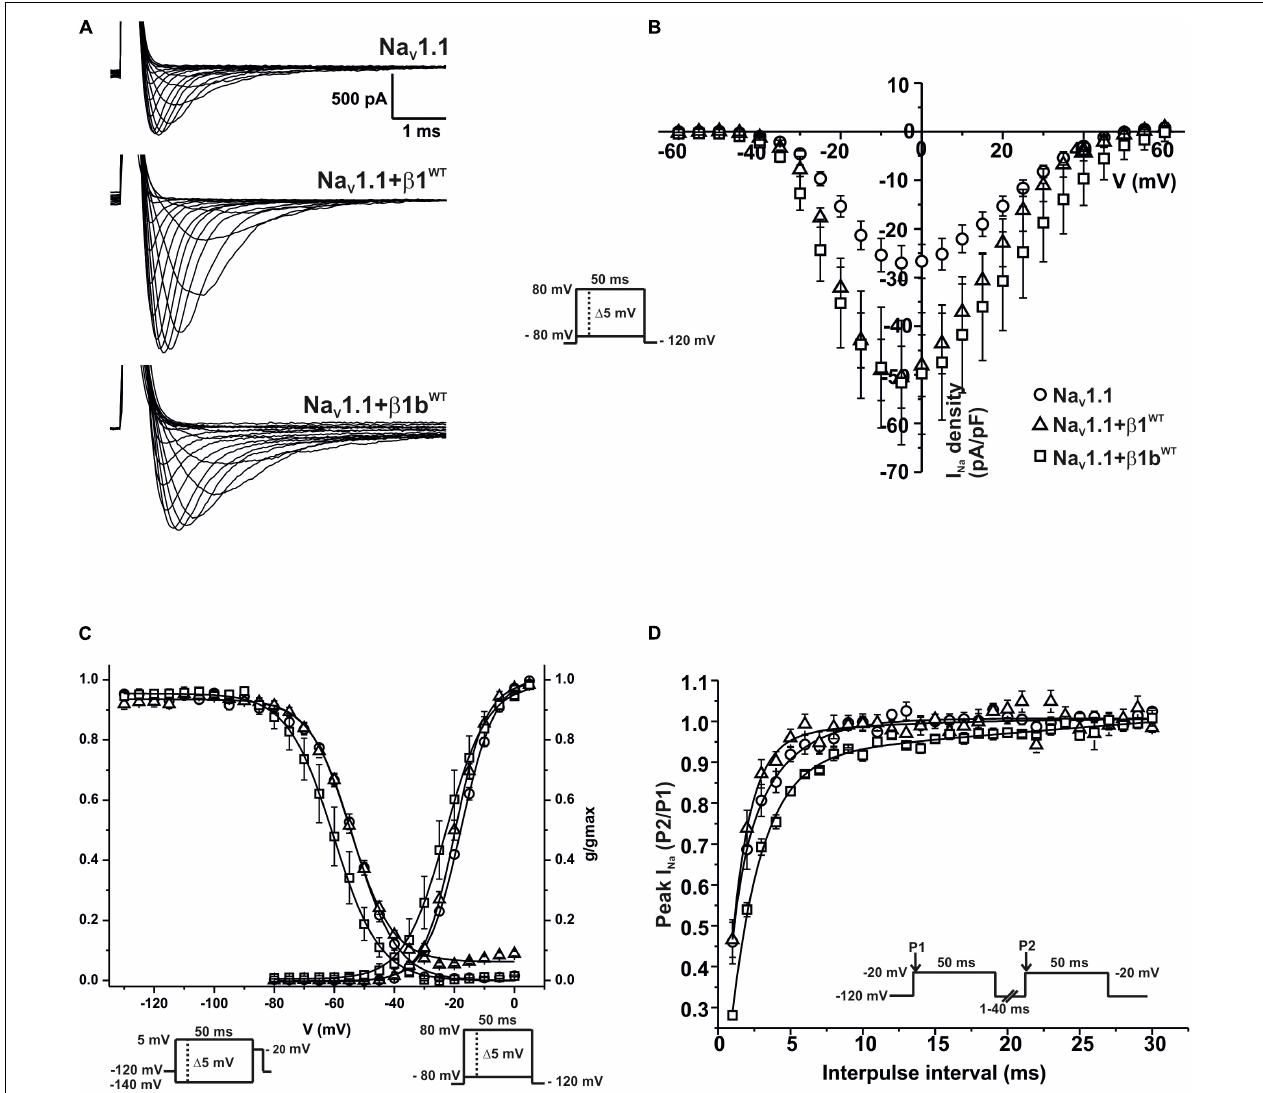
FIGURE 6 | β 1 WT and β 1b WT modulate Na V 1.1 current. Biophysical properties of sodium currents measured from HEK-293T cells expressing Na V 1.1 alone, or co-expressed with either β 1 WT or β 1b WT . Whole cell currents were elicited by depolarizing potentials as shown in the insets. Circles are used to depict data for Na V 1.1 alone, triangles for Na V 1.1+ β 1 WT , and squares for Na V 1.1+ β 1b WT . Solid lines in panels (C) and (D) represent the fitted curves. Values are expressed as mean ± SEM. (A) Representative whole-cell Na + current traces from HEK-293T cells expressing Na V 1.1 alone (top), Na V 1.1+ β 1 WT (middle), and Na V 1.1+ β 1b WT (bottom). (B) Mean current-voltage relationship. I Na amplitude was normalized by the cell capacitance to obtain I Na density values. (C) I Na steady-state voltage dependence of activation and inactivation plots. (D) Recovery from inactivation curves.